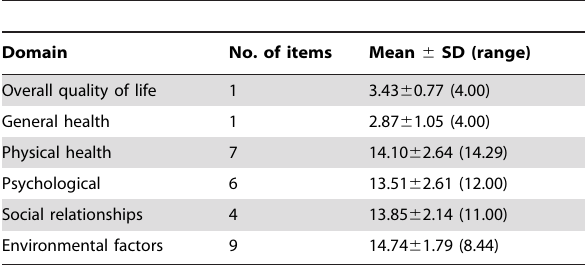
Table 2. Descriptive analysis of patients’ quality of life (QOL) scores ( n